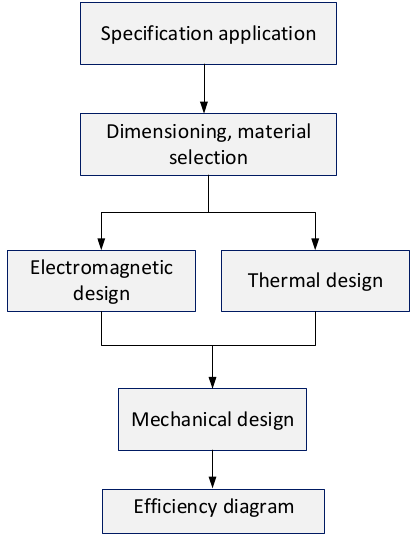
Figure 2. Overview of conventional electric machine design [29].